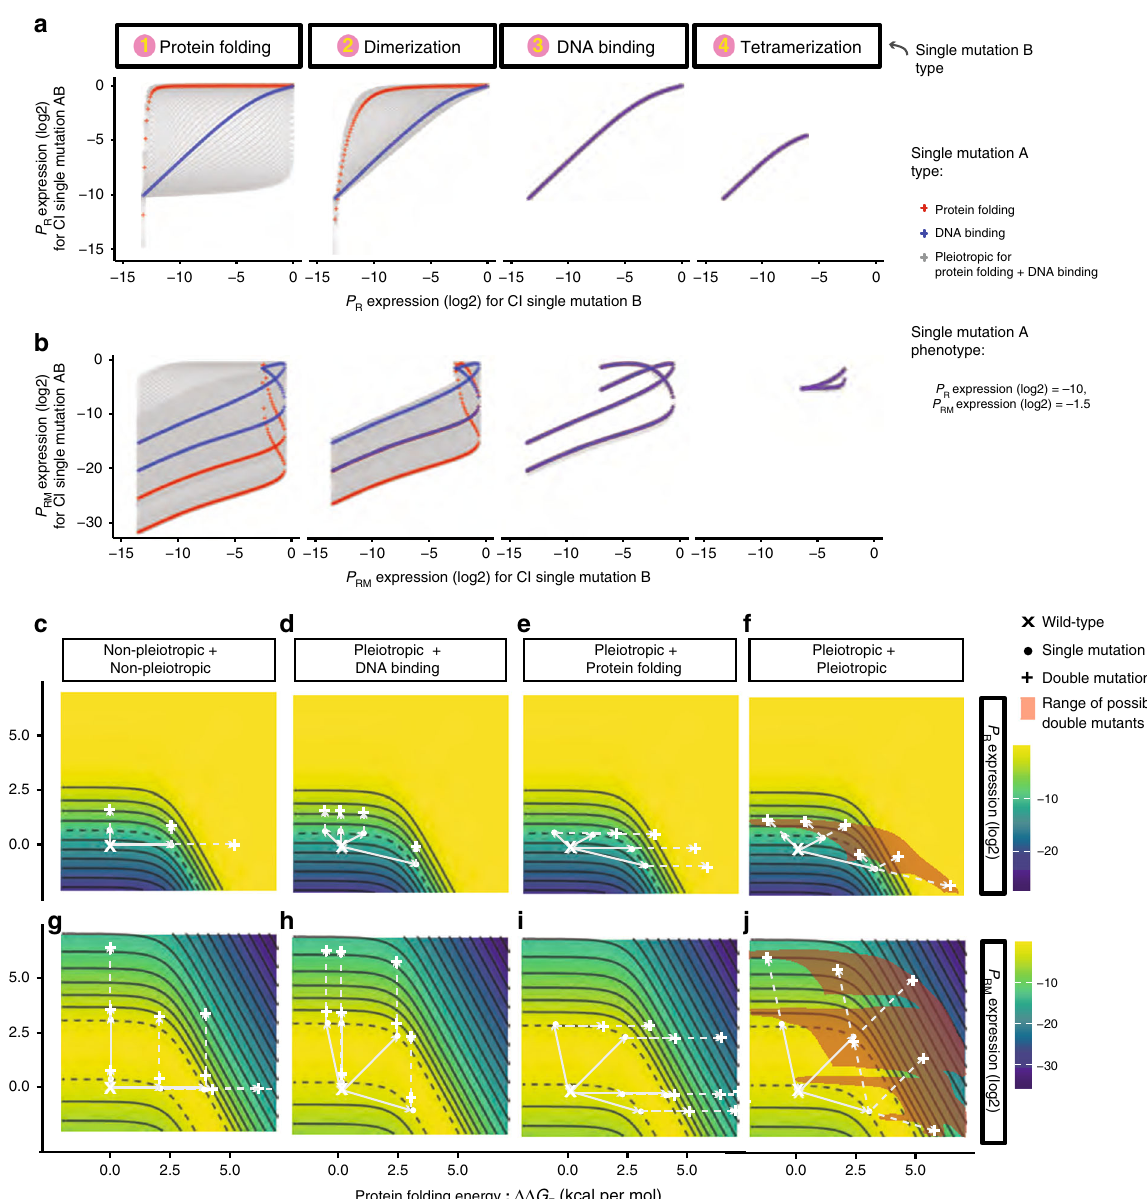
Fig. 4 Biophysical pleiotropy further confounds phenotype prediction. a , b Double mutant phenotypes when pleiotropic mutations (Mutation A) variably affecting folding and DNA binding to give P R expression = − 10 ( a ) and P RM expression = − 1.5 ( b ) in log(2) scale are combined with different types of mutations (Mutation B). c – j Free-energy-phenotype landscapes for mutations that affect the free energy of folding ( x -axis) and/or DNA-binding energy ( y -axis). Phenotypic isochores are drawn with an interval of 2 in log(2) scale. A continuous range of free-energy changes can underlie an observed phenotype (dashed isochore). Combining two mutations with the same effect can result in a range of double mutant phenotypes (red shaded areas in ( f ) and ( j )). Example double mutant outcomes are shown when neither ( c , g ), one ( d , e , h , i ) or both ( f , j ) mutations are pleiotropic. Source data are provided as a Source data fi folding are horizontal movements in this space, mutations that only affect DNA binding are vertical movements and pleiotropic mutations are diagonal movements. All of the changes in free energy that result in the same phenotype form a phenotype iso- chore, for example the grey dashed curves in Fig. 4c – f represent all parameter changes that can produce a 4-fold increase (2 in log (2) scale) in P R expression. When two non-pleiotropic mutations that cause this same phenotypic change (lie on the same phenotype isochore) are combined together there are three possible combinations of free- energy changes (the two mutations alter DNA binding, folding, or